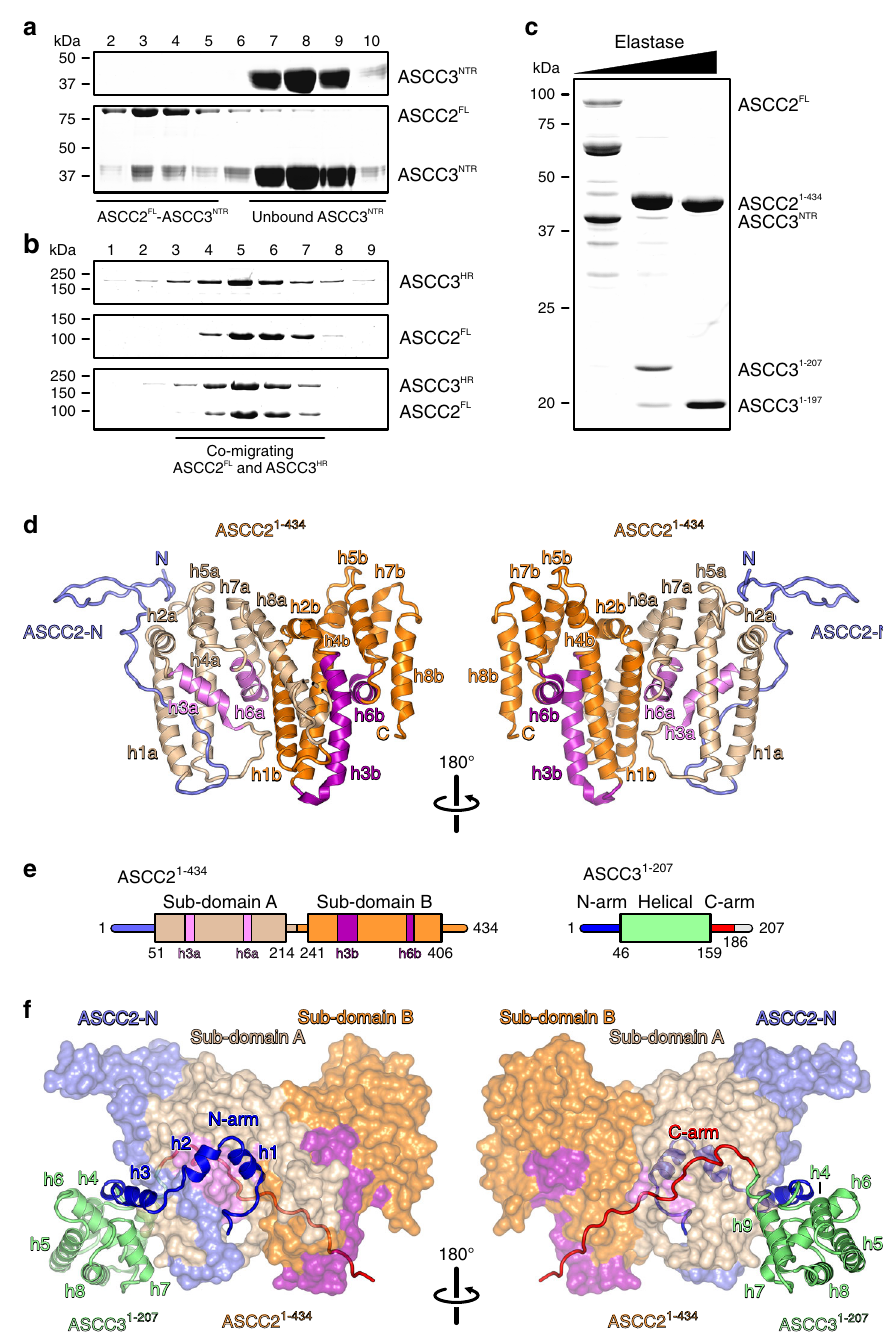
Fig. 1 Delineation of a minimal ASCC2 – ASCC3 complex and structural overview. a , b SDS-PAGE analysis of SEC runs monitoring interaction of ASCC2 FL and ASCC3 NTR ( a ) and lack of interaction between ASCC2 FL and ASCC3 HR ( b ). In this and following fi gures: kDa, molecular weights of molecular weight markers in kDa. c SDS-PAGE analysis of elastase treatment of the ASCC2 FL -ASCC3 NTR complex. Bands running between ASCC2 FL and ASCC2 1 – 434 represent intermediate ASCC2 fragments that occur transiently in the course of the digestion. Experiments shown in a – c have been repeated independently at least three times with similar results. d Orthogonal cartoon plots of ASCC2 1 – 434 . ASCC2-N, N-terminal extension, slate blue; helices in sub-domain A, beige and violet; helices in sub-domain B, orange and purple. Helices are labeled as in the text. N, N-terminus; C, C-terminus. e Schemes of the domain organizations of ASCC2 1 – 434 and ASCC3 1 – 207 . Violet and purple bars in the ASCC2 1 – 434 scheme represent helices h3a/b and h6a/b. The C-terminal 21 residues of ASCC3 1 – 207 (gray line) are not de fi ned in the electron density. f Orthogonal views on the ASCC2 1 – 434 -ASCC3 1 – 207 complex, with ASCC2 1 – 434 as surface view and ASCC3 1 – 207 as cartoon. ASCC2 1 – 434 , colored as in d . N-arm of ASCC3 1 – 207 , blue; C-arm of ASCC3 1 – 207 complex, red; helical domain of ASCC3 1 – 207 , lime